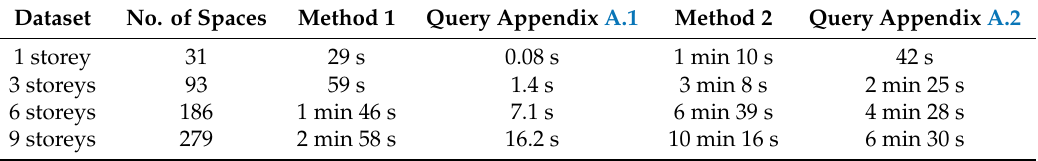
Table 1. Results of processing of the 3D cadastral datasets for the first and the second method.